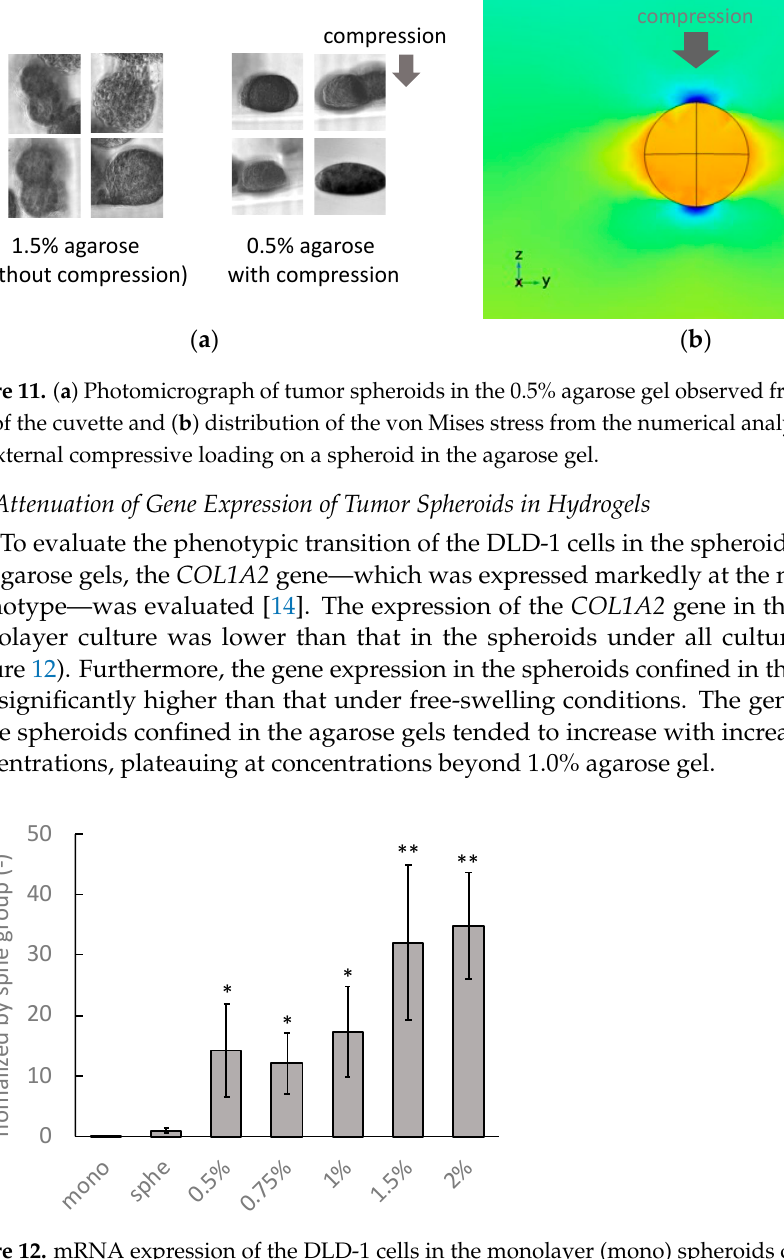
Figure 12. mRNA expression of the DLD-1 cells in the monolayer (mono) spheroids cultured under free-swelling conditions (sphe), and spheroids cultured in agarose gel of different mass concentrations (0.5–2%). * indicates a significant difference compared to the sphe group ( p < 0.05). ** indicates a significant difference compared to the 0.5% group ( p < 0.05).